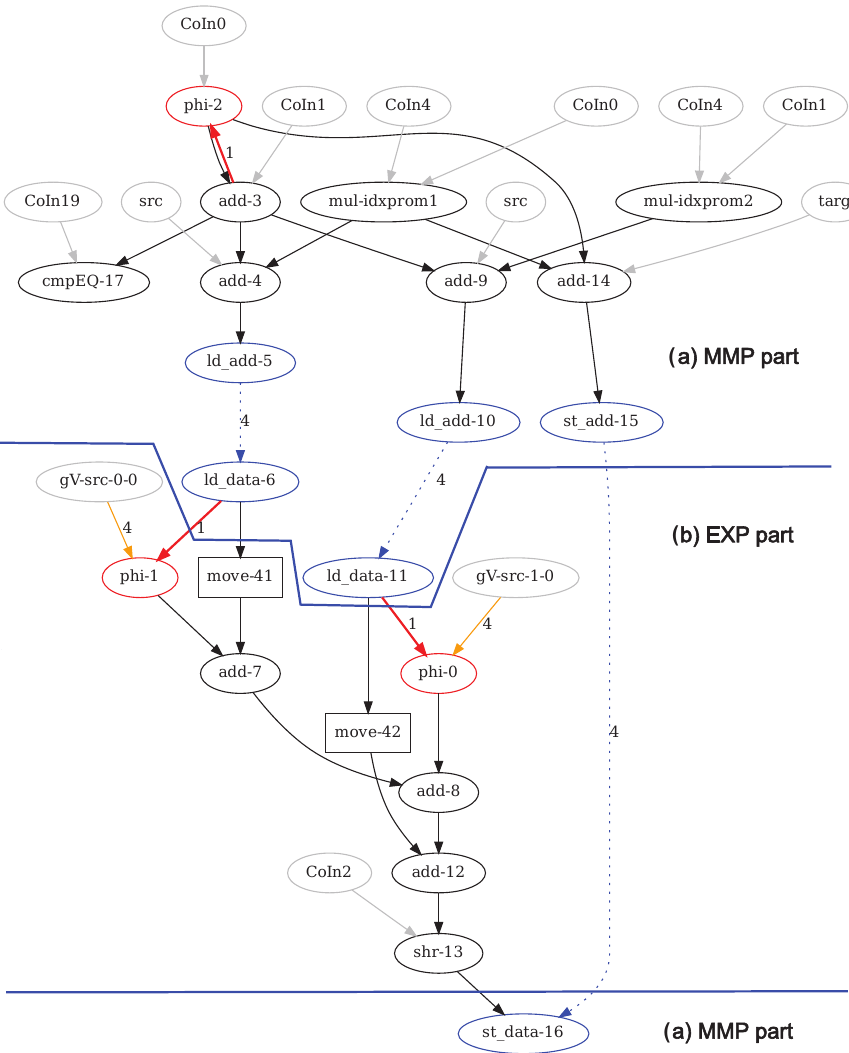
Figure 3. Example 1: Boxfilter’s Data Dependence Graph (as generated by DDDGen), with separated ( a ) MMP and ( b ) EXP